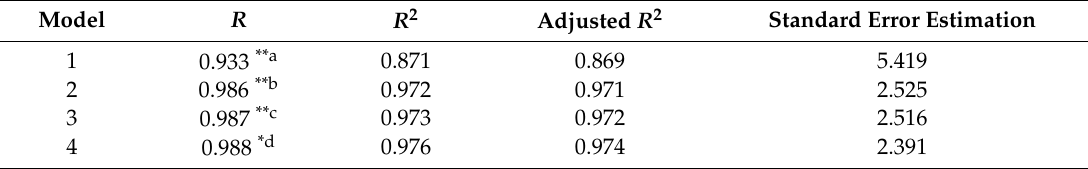
Table 1. The results of the regression analysis of anthocyanin content. Model